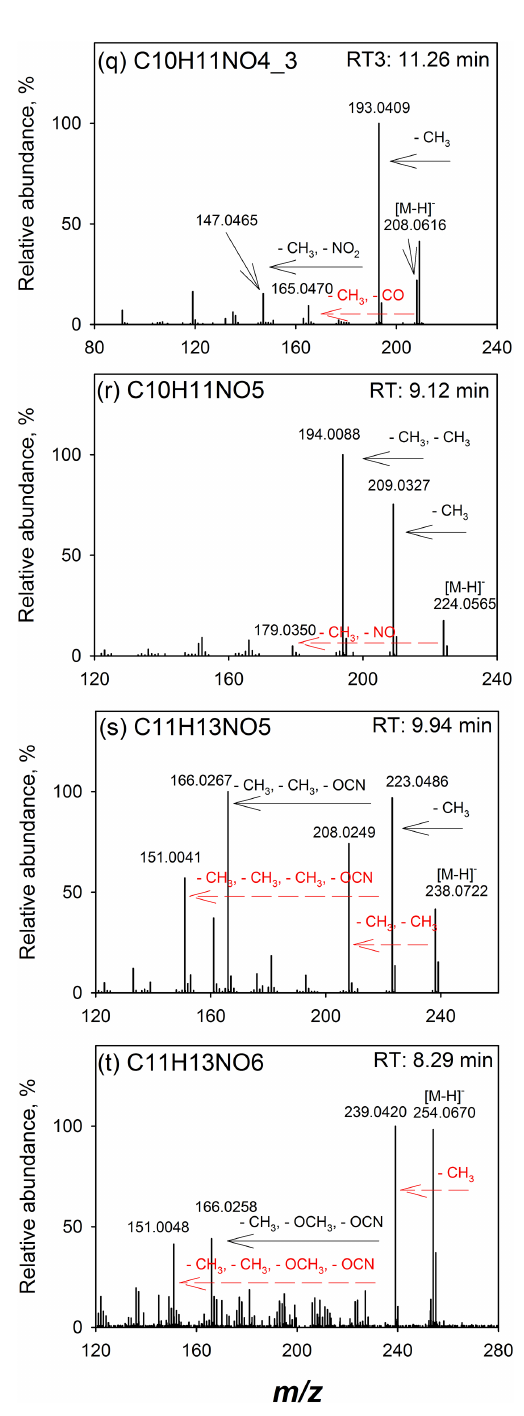
Figure 1. Q-ToF MS / MS spectra of (a) C 6 H 5 NO 3 , (b) C 6 H 5 NO 4 , (c, d) C 7 H 7 NO 4 isomers, (e) C 6 H 5 NO 5 , (f, g) C 8 H 7 NO 4 iso- mers, (h, i) C 8 H 9 NO 4 isomers, (j) C 7 H 7 NO 5 , (k) C 10 H 7 NO 3 , (l, m) C 9 H 9 NO 4 isomers, (n) C 8 H 9 NO 5 , (o–q) C 10 H 11 NO 4 isomers, (r) C 10 H 11 NO 5 , (s) C 11 H 13 NO 5 , and (t) C 11 H 13 NO 6 identified in the flaming-phase sample collected during the NC forest 1 experi- ment, burn 2 (Table